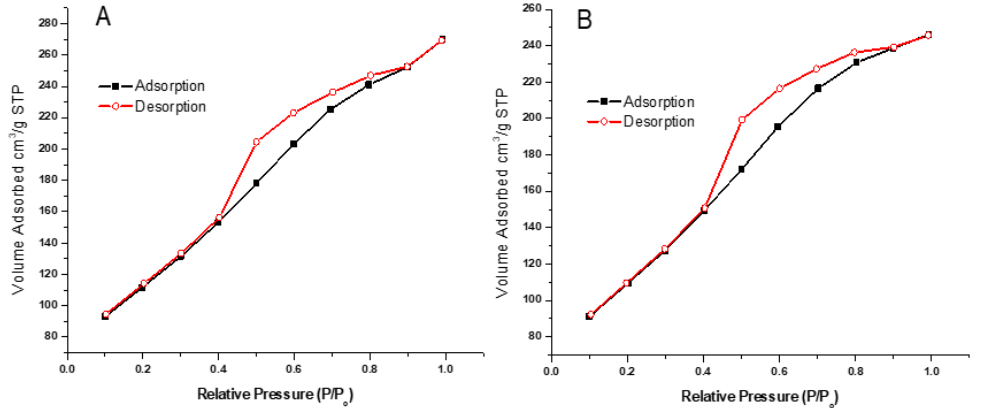
Figure 3. N 2 adsorption–desorption isotherm of the ultrasonically ( A ) and non-ultrasonically ( B ) prepared 1%Pd-HPW/SiO 2 bi-functional catalysts.